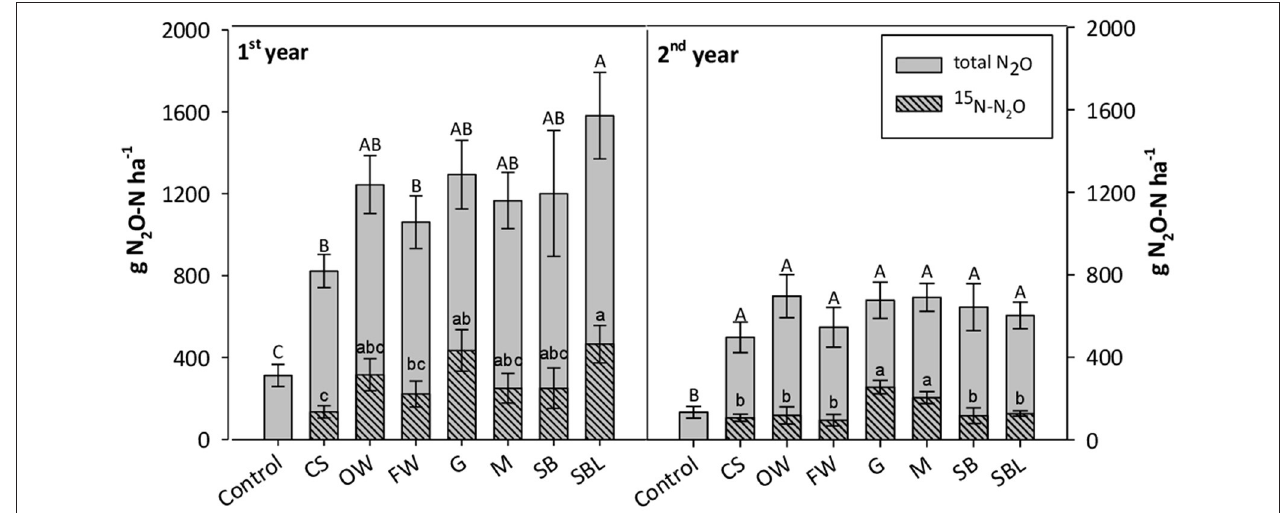
FIGURE 4 | Total cumulative N 2 O-N emissions derived from digestate ( 15 N-N 2 O) 55 (1st year) and 58 days (2nd year) after digestate application. In both years, measurements were conducted from May to July. Unfertilized soil served as control. Digestates from cattle slurry (CS), organic waste (OW), food waste (FW) were 15 N-labeled only in NH + 4 -N; digestates based on grass (G), maize (M), grass (G), sugar beet (SB), and sugar beet leaves (SBL) were N). Error bars show standard error ( n = 4). Different letters indicate significant differences at p < 0.05 (Tukey Test); Capital letters refer to total N 2 O and small letters to 15 N-N 2 O.